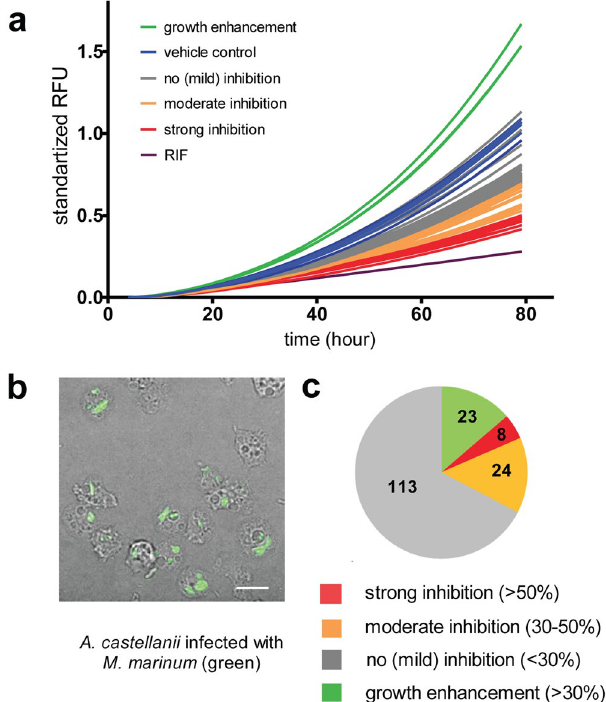
Figure 3. Characterization of anti-infective activities of GSK TB-set compounds in protozoan infection assay. ( a ) Growth kinetics of M. marinum msp12::GFP in A. castellanii infection, 10 5 A. castellanii were transferred to the wells, 60 hours incubation time, PYG medium and in the presence of 10 μ M corresponded compounds from GSK TB set. ( b ). Phase contrast/fluorescence microscopy of A. castellanii infection with M. marinum msp12::GFP. The scale bar corresponds to 30 μ m. ( c ) Pie chart representing summarized results of growth inhibitory activity of 168 compounds in A. castellanii infection assay. The analyzed set included compounds that displayed inhibition of more than 50% normalized RFU (red), moderate inhibition between 30 and 50% (red), compounds that showed less than 30% inhibition (grey) and compounds that displayed increase of RFU by more than 30% (green). The scale bar corresponds to 200 µ